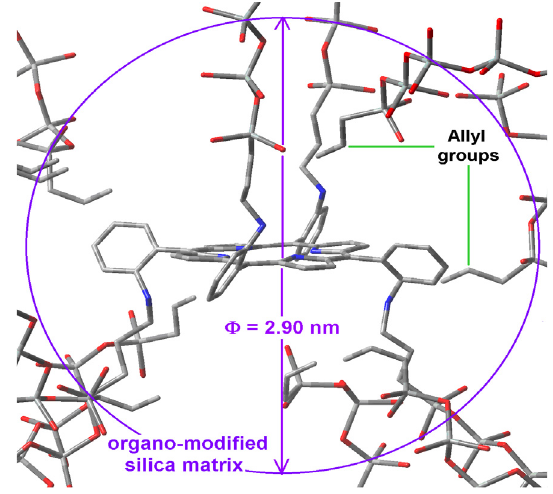
Figure 10. Hypothetical structure of a pore containing the H covalently bonded through the use of IPTES to the pore walls of silica modified with allyl